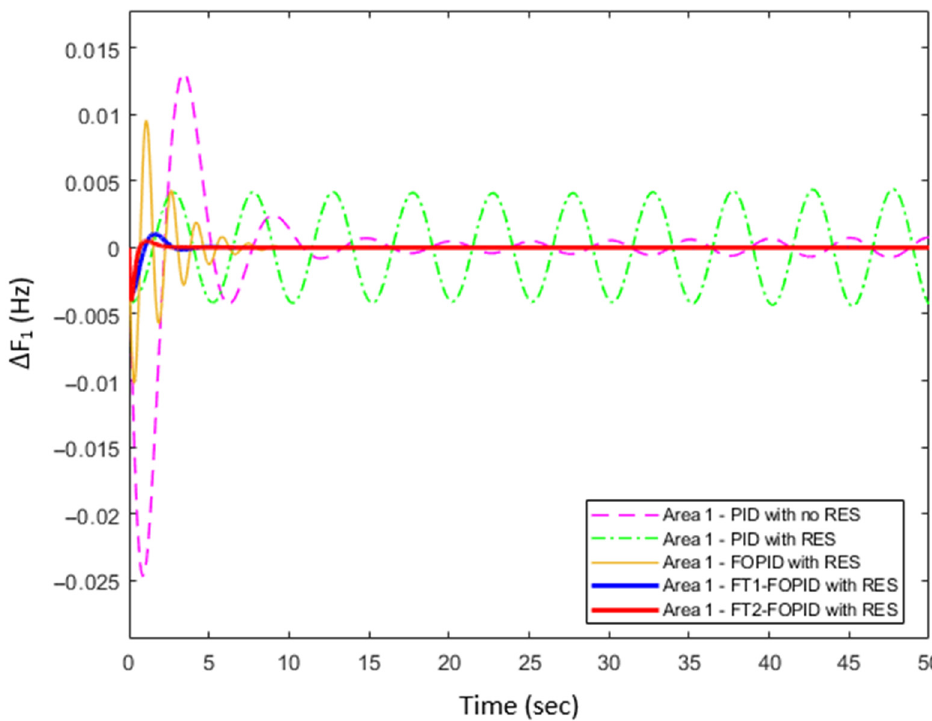
Figure 11. Results for 1% load alteration in Area 1.